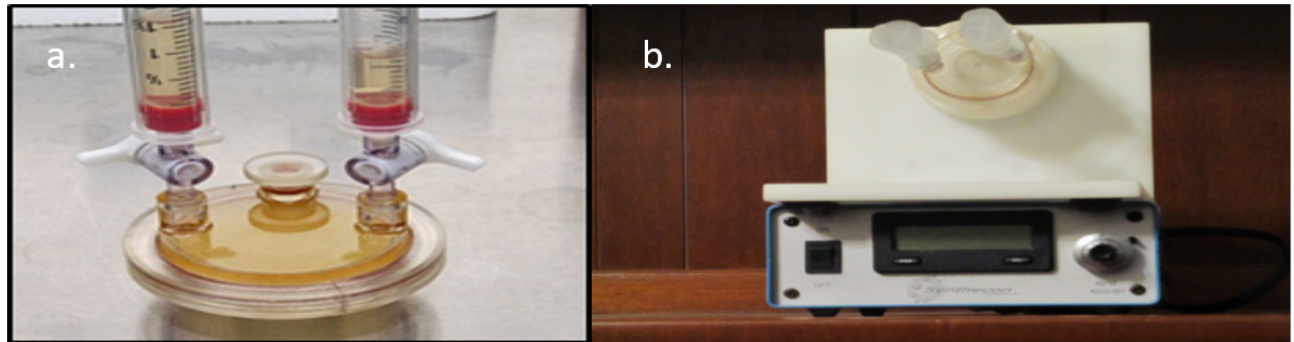
Figure 1. ( a ) Rotating cell culture system bioreactor (10.0 mL) used to develop the 3 ‐ D embryonic tick cell models. Syringes are attached to the air purging ports. ( b ) Bioreactor mounted on rotating base and controller.